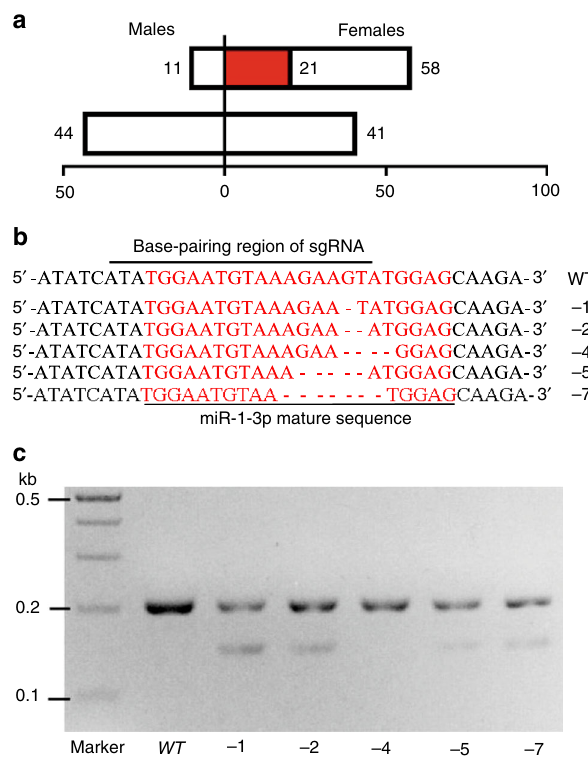
Fig. 7 CRISPR/Cas9 induced genomic disruption of miR-1-3p. a The sexual phenotype of wild type ( wt ) adults having an miR-1-3p knock-out deletion (miR-1-3p − ) mediated by CRISPR/Cas9. CK is the control group injected with Cas9-mRNA and egfp sgRNA. Individuals with mutations in miR-1-3p target sites (red bar) are presumed to be feminized XY chromosomal males based on an expected 1:1 sex ratio and the number of estimated true XX chromosomal females (white bar). ( b ) Deletion products in fi ve G0 fl ies ( − 1, − 2, − 4, − 5, and − 7 deletion mutations) resulting from non-homologous end-joining of the targeted genomic sequence by miR-1- 3p sgRNA. ( c ) PCR products ampli fi ed from WT and mutant G0s treated with T7 Endonuclease I (T7EI) where additional shorter products detected in mutants represent the different miR-1-3p